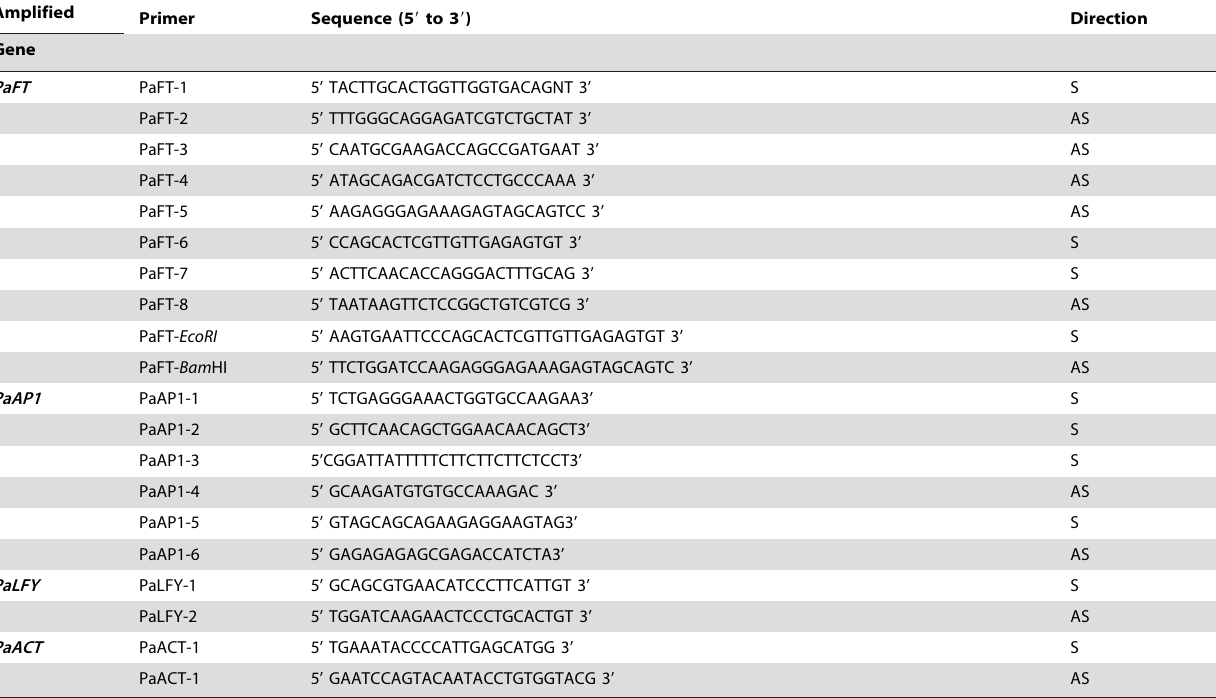
Table 1. Primers used in this study.